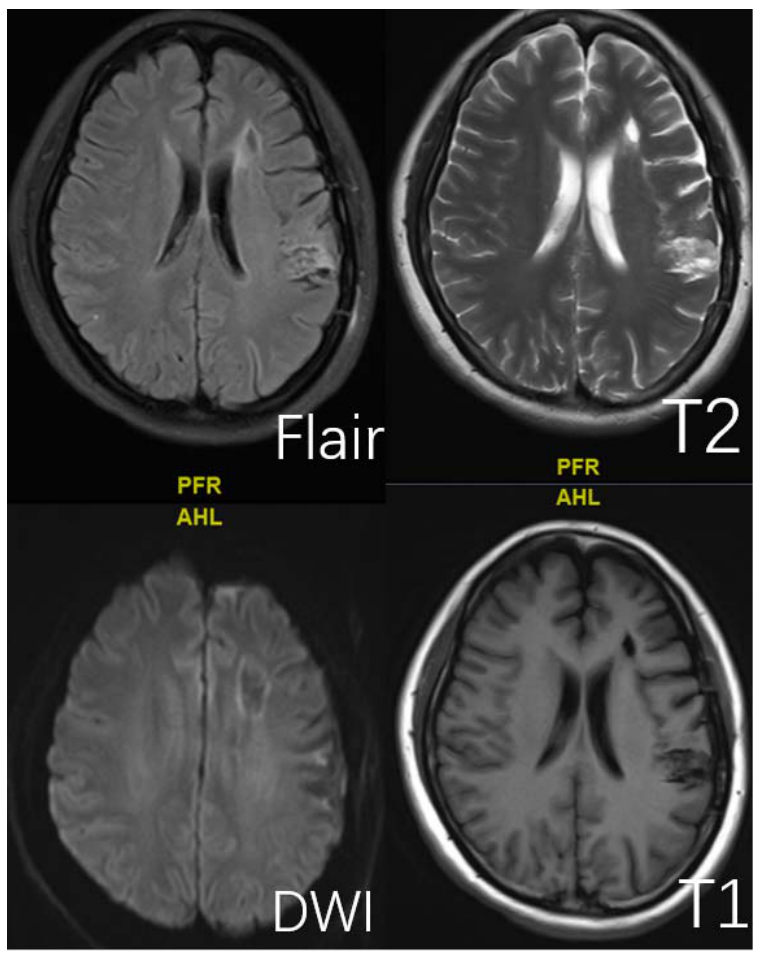
Figure 3. This is a 45-year-old female. Typical presentation of old cerebral infarction on T1, T2, DWI, and Flair sequences.